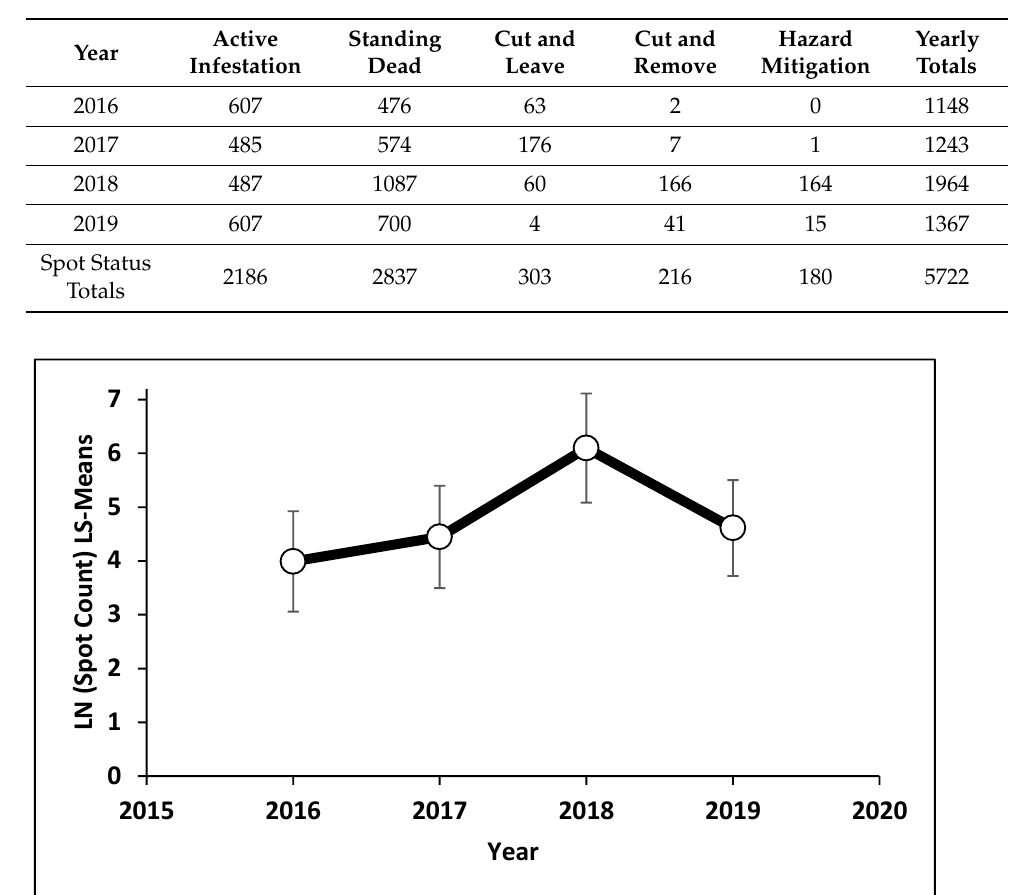
Figure 3. Least squares means for logged southern pine beetle treated spots on the Bienville National Forests for years 2016 to 2019 across all statuses. Error bars represent lower and upper 95% confidence intervals.